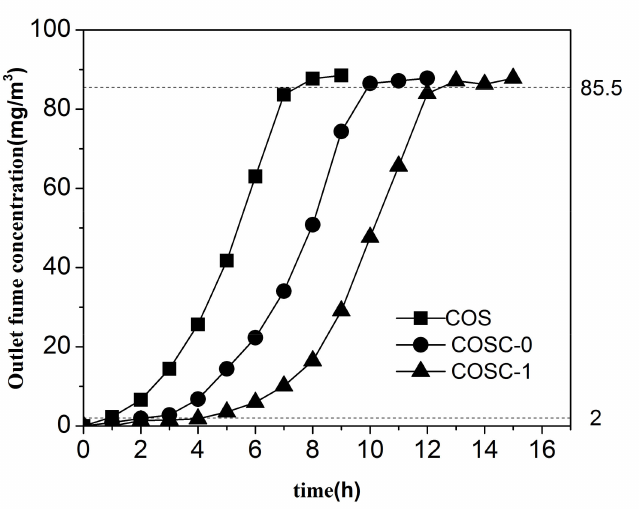
Figure 2. Adsorption breakthrough curves of different adsorbents for cooking fumes ( GHSV : 4300/h, T = 25 ◦ C, C 0 = 90 mg/m 3 , H = 30 cm).